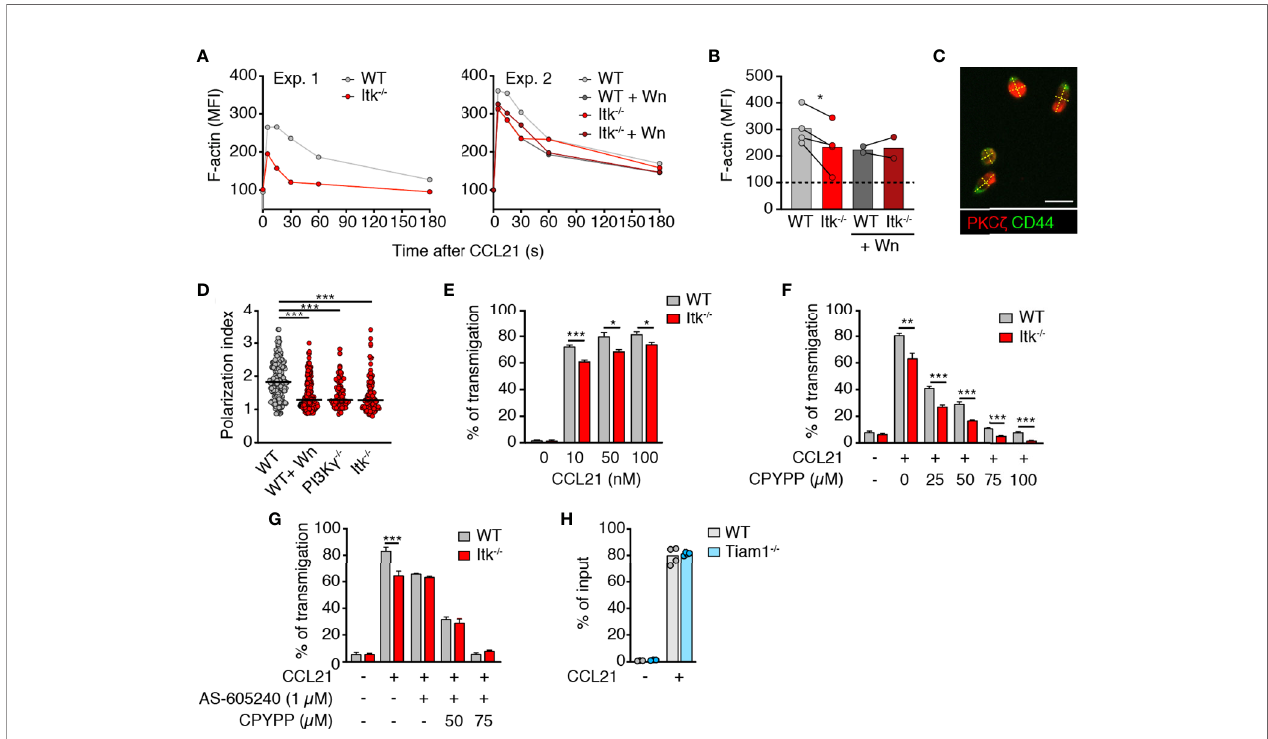
FIGURE 1 | Itk enhances CCL21-induced polarization and migration of T cells. (A) MFI of F-actin after CCL21 stimulation with and without Wn treatment. (B) Summary of normalized F-actin MFI at 30 s post CCL21 addition (100 = baseline). Experiments performed on the same day (i.e., same fl ow cytometer settings) are linked with a line. (C) Image of CCL21-stimulated T cells on fi bronectin-coated glass dish. Scale bar, 10 µm. (D) Quanti fi cation of cell polarization as measured by the ratio between the length and the width of the cellular body (dotted yellow lines in C). (E) Chemotaxis of WT and Itk -/- CD4 + T N to indicated CCL21 concentrations. (F, G) Chemotaxis of WT and Itk -/- CD4 + T N pretreated with CPYPP (F) and/or AS-605204 (G) toward 50 nM CCL21. Graph shows percentage of transmigrated cells. (H) Chemotaxis of WT and Tiam1 -/- CD4 + T cells toward 50 nM CCL21. Graph shows percentage of transmigrated cells. Data in (B) were analyzed using a paired t-test. Data in (D – H) are pooled from at least two independent experiments and analyzed by Kruskal – Wallis test (D) or unpaired Student ’ s t-test (E – H) . *p < 0.05; **p < 0.01; ***p <